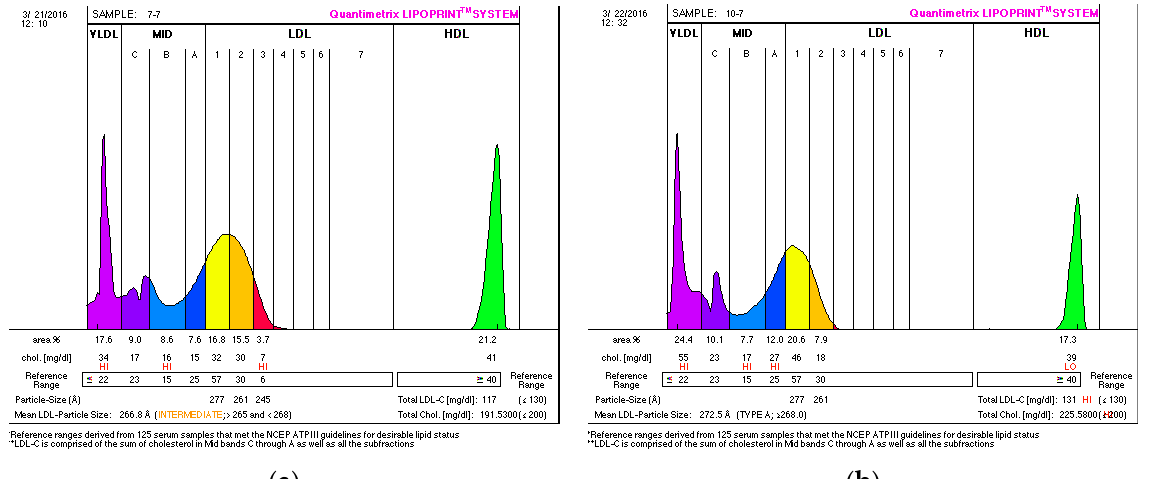
Figure 1. A representative lipoprotein profile of one proband from NTC group at baseline ( a ) and after consumption ( b ) of bitter apricot seeds. Atherogenic subfractions LDL 3–7 are in red; the large—less atherogenic subfractions LDL 1 and LDL 2 are in yellow.